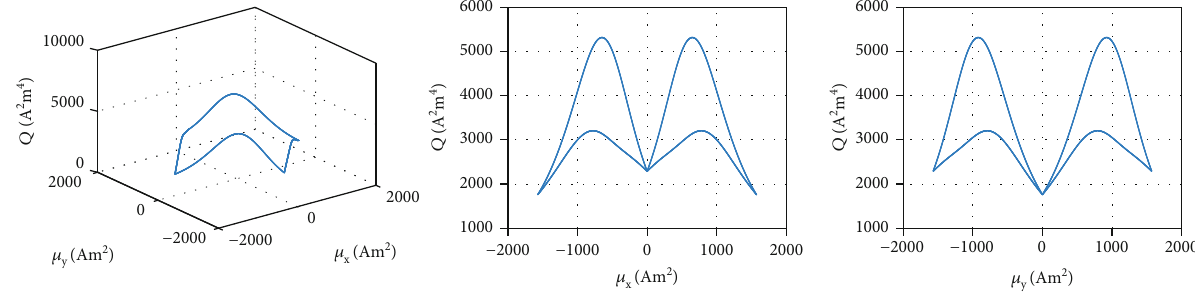
Figure 9: The desired force is [0.2N, 0.3N, 0] T .